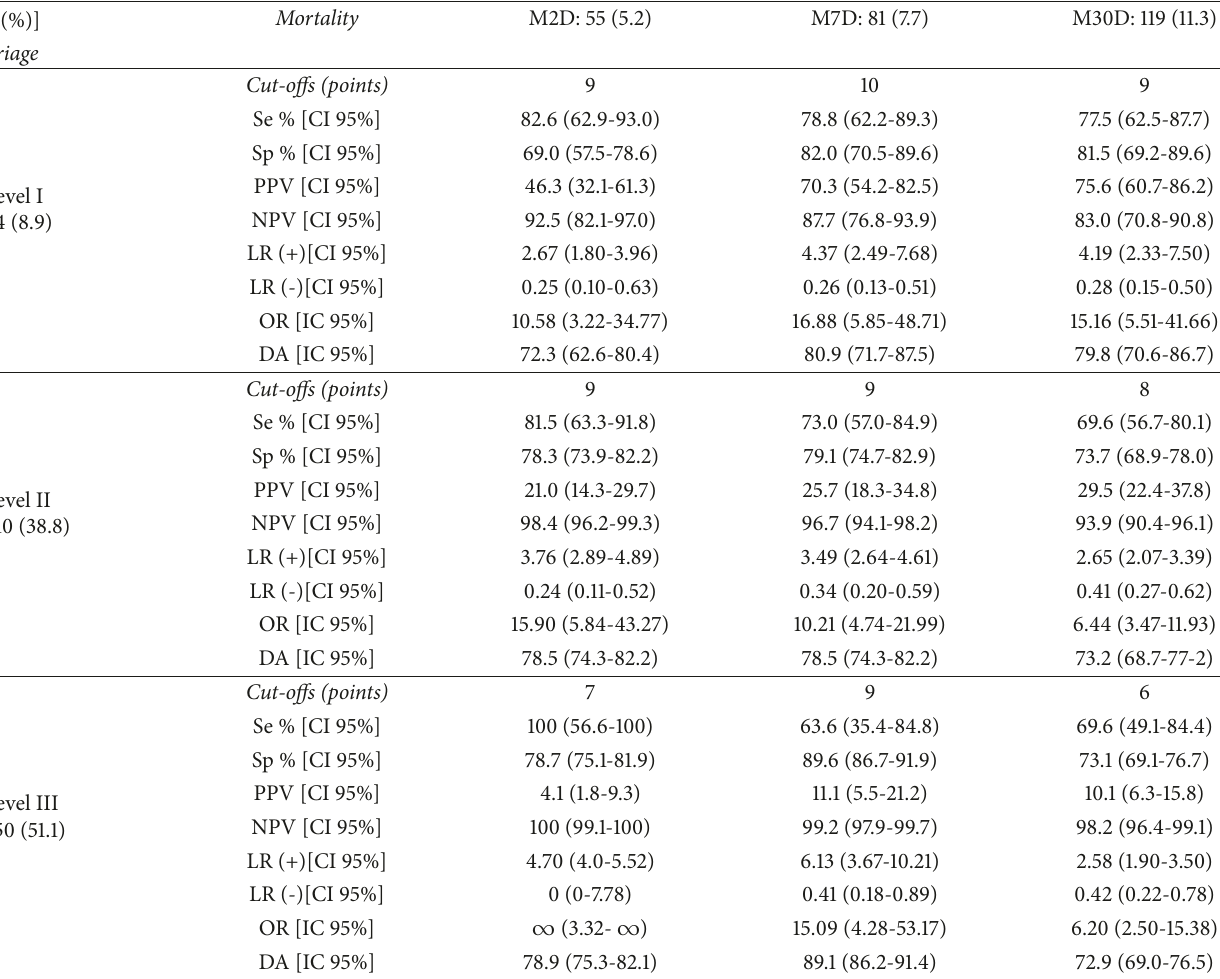
Table 2: Cut-off points for combined sensitivity and specificity with best score (Youden test) on the NEWS2 scale as a function of mortality (2, 7, and 30 days) and of the assigned triage